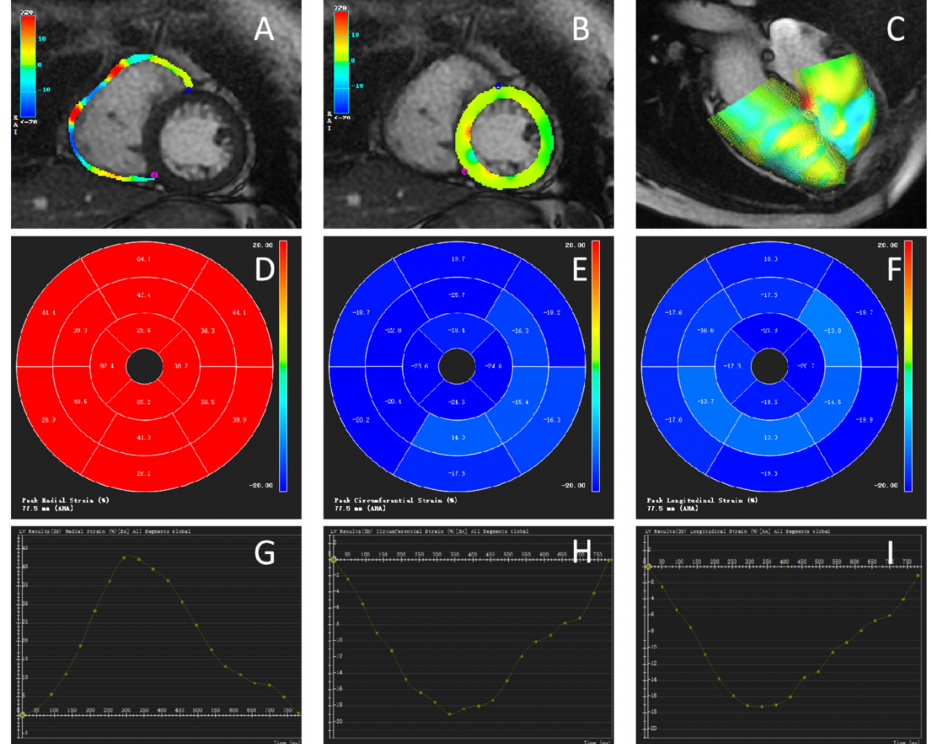
Figure 2. Cardiac magnetic resonance tissue tracking (CMR-TT) in the same patient with PAH shown in Figure 1. ( A – C ) Global radial strain of the ventricles in diastole. Color coding represents the tracking for the ventricle. ( A ) Right ventricle. ( B ) Left ventricle. ( C ) 3D model of the left and right ventricles in diastole. The color coding represents the epicardial contours. ( D – F ) Polar map of 2002 American Heart Association segmentation. ( D ) Radial strain (RS). ( E ) Circumferential strain (CS). ( F ) Longitudinal strain (LS). ( G – I ) Curve showing the strain values of the left ventricle in 25 phases, including the peak value. ( G ) RS. ( H ) CS. ( I )